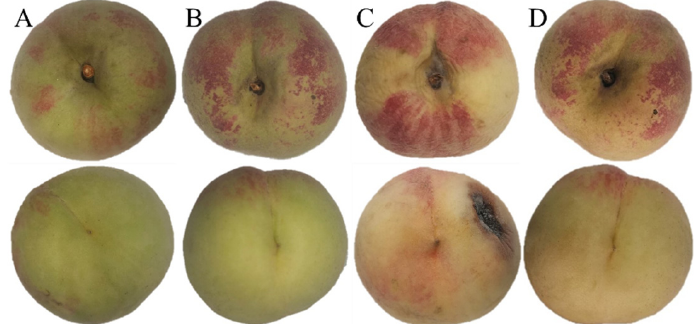
Figure 1. Appearance of peaches before and after storage at 5 °C for 35 days. ( A ), control at time 0; ( B ), combination at time 0; ( C ), control after 35 days; ( D ), combination after 35 days.